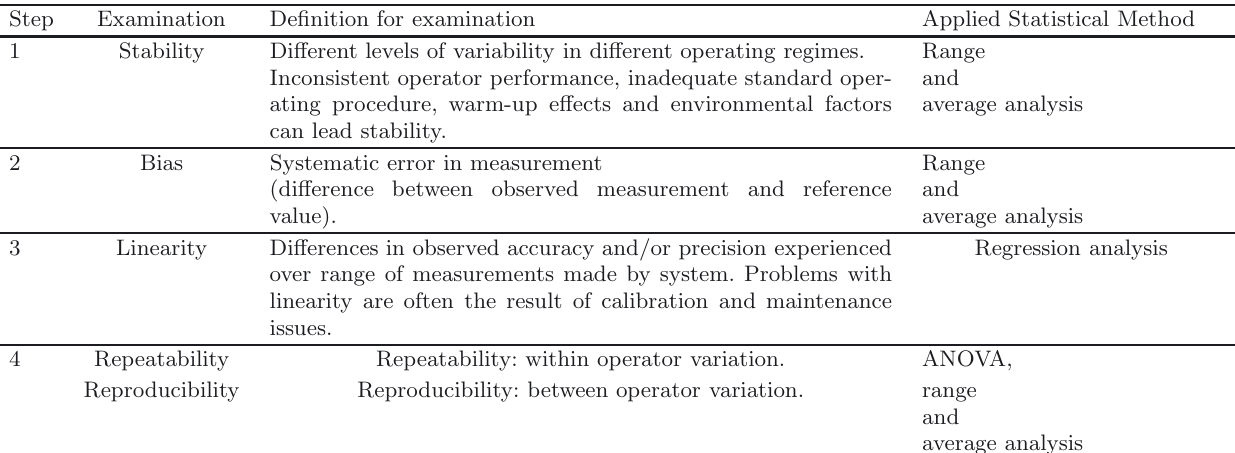
Table 1. Methods applicable in the automotive industry for evaluating measurement capability, adopted from